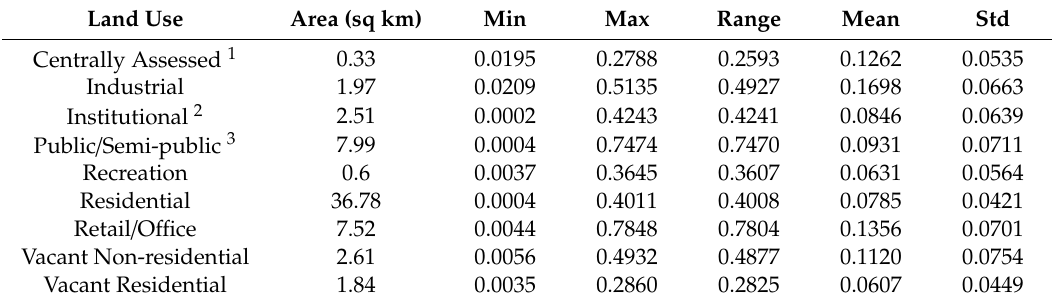
Table 4. Zonal statistics of NBI derived from 22 October 2016 Landsat 8 OLI data, referencing FGDL